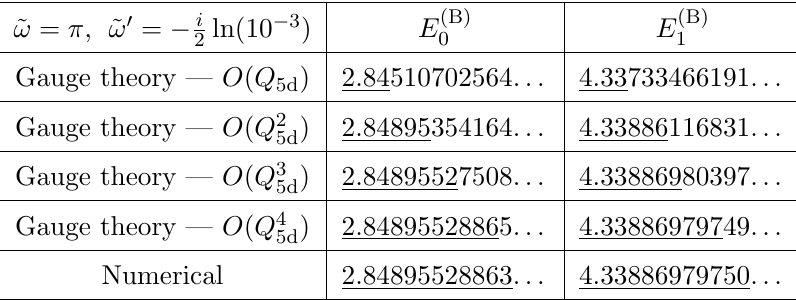
Table 7 . Energies for the 2-eRS B model (3.9) at g x = 2, ~ x = 1.